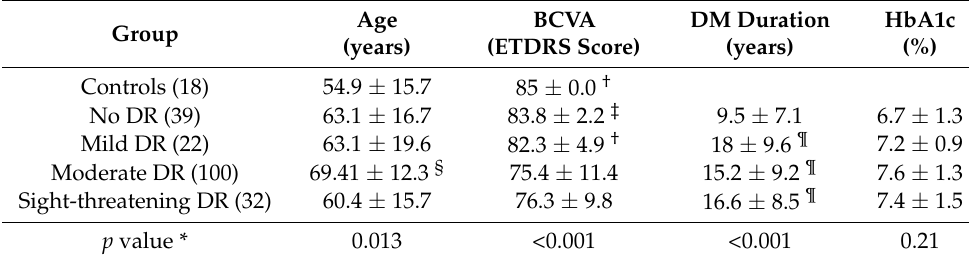
Table 1. Main demographic and clinical data of the study population.